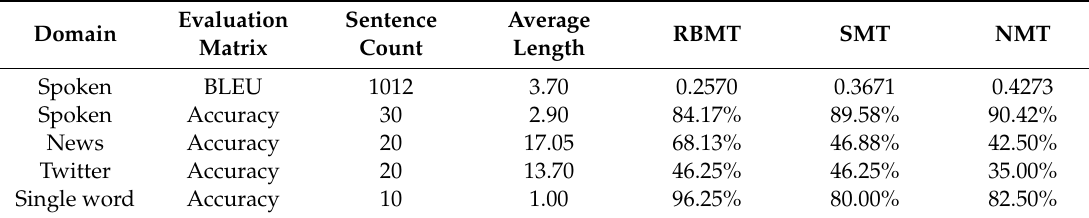
Table 1. Translation quality comparison of rule-based machine translation (RBMT), statistical-based machine translation (SMT), and neural machine translation